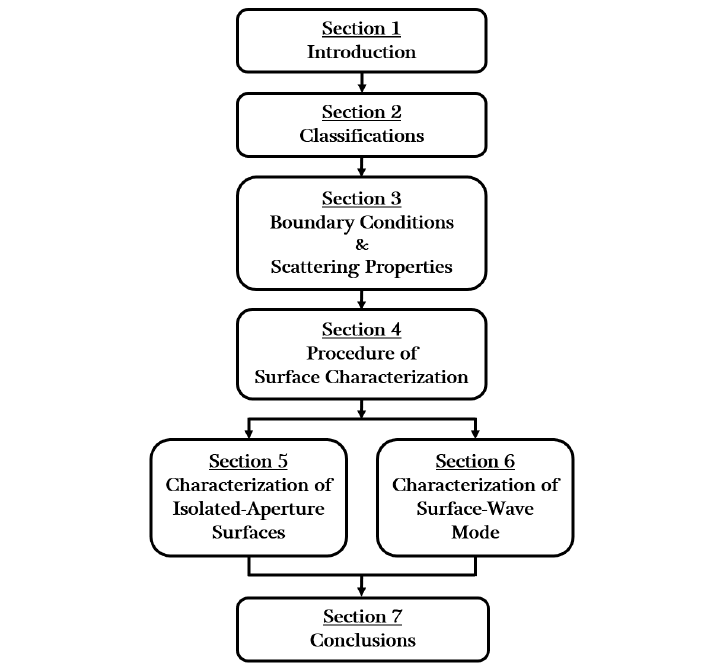
Figure 3. Organization of this